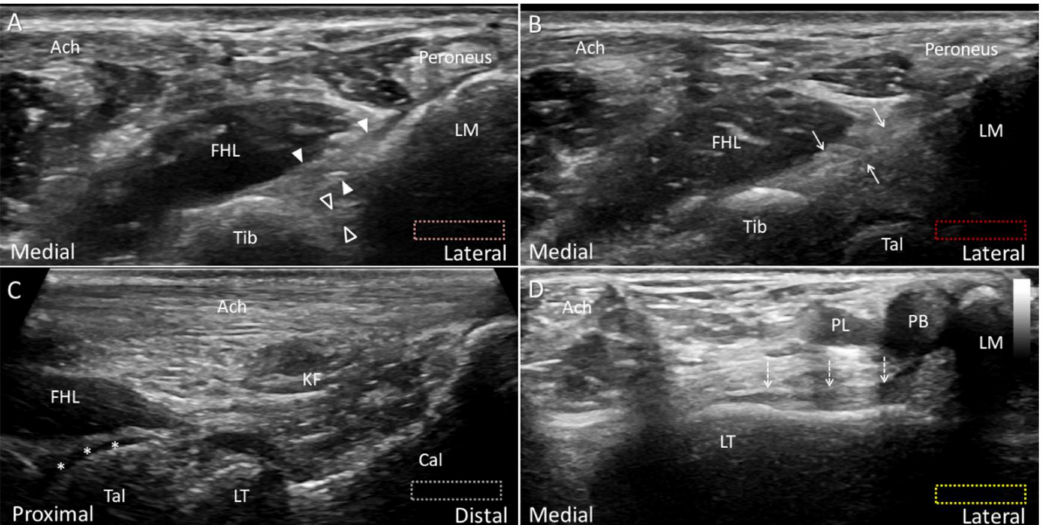
Figure 5. Ultrasound imaging of the posterior–inferior tibiofibular ligament (arrowheads, superficial component; void arrowheads, deep component) ( A ) and the intermalleolar ligament (arrows) ( B ). Placing the transducer along the long axis of the Achilles tendon (Ach), the lateral tubercle (LT) of the posterior talar process is visualized just cephalad to the posterior subtalar joint ( C ). Note the cartilage (asterisks) on the talar dome. As the lateral edge of the transducer is pivoted toward the lateral malleolus (LM), the posterior talofibular ligament (dotted arrows) is visualized lying on the talus ( D ). The di ff erent colored dashed rectangles are in accordance with the transducer positions in Figure 2B. Cal: calcaneus; FHL: flexor hallucis longus; KF: Karger’s fat pad; PB: peroneus brevis; PL: peroneus longus; Tib: